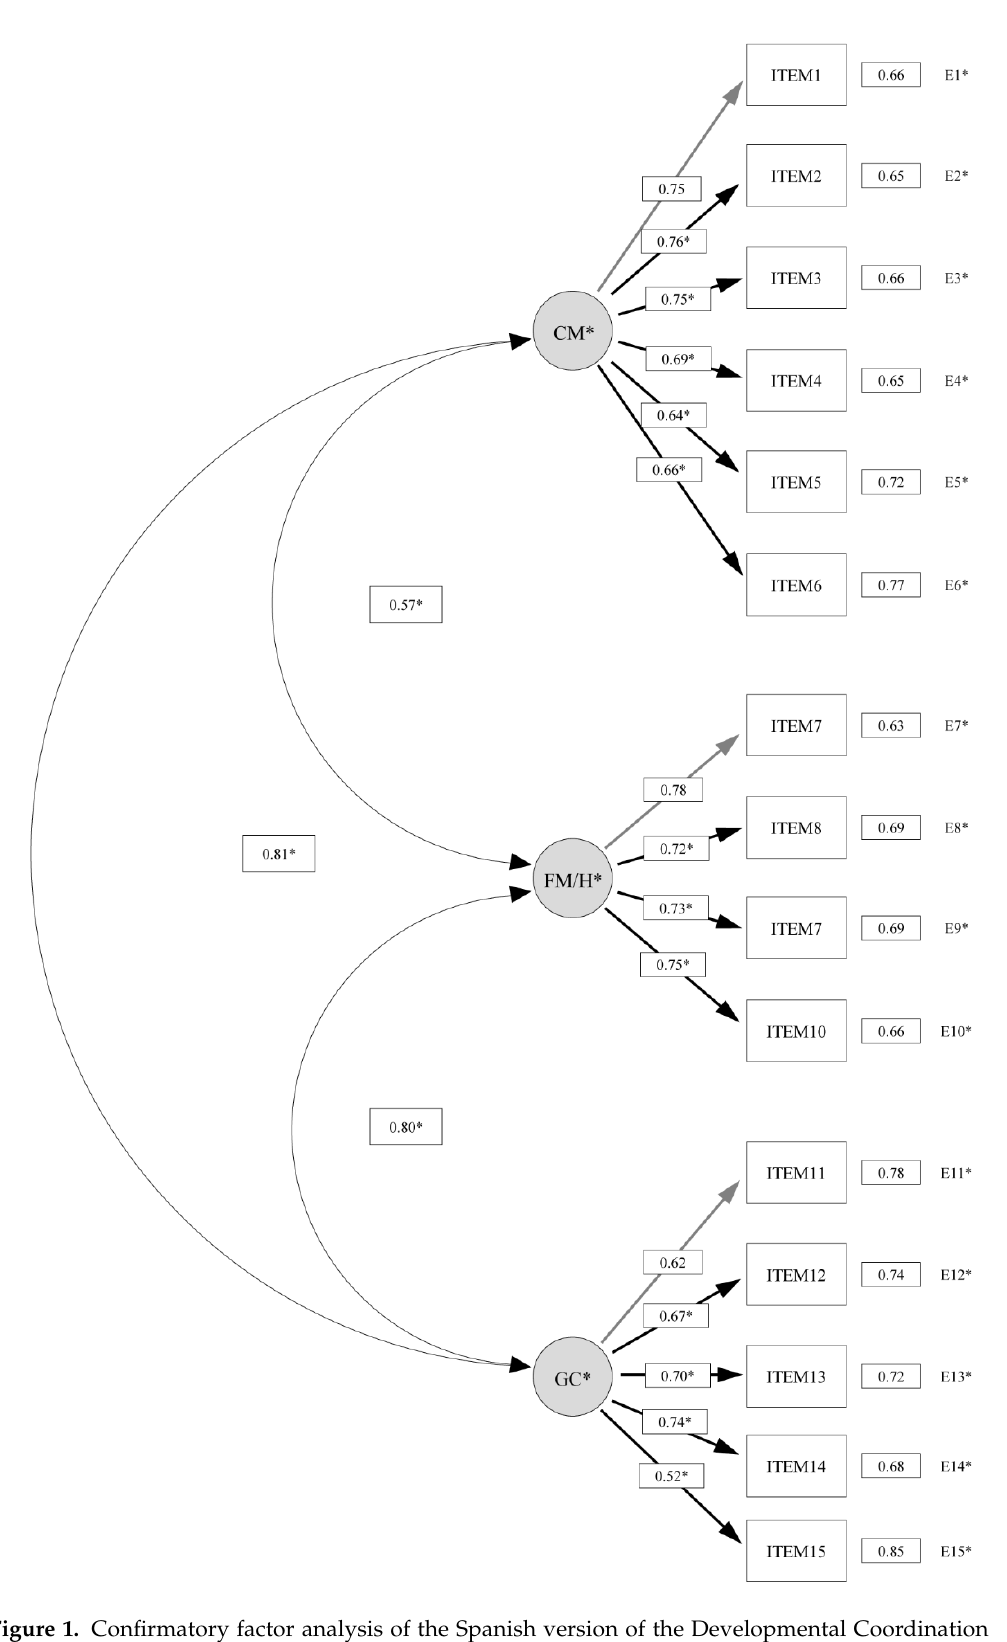
Figure 1. Confirmatory factor analysis of the Spanish version of the Developmental Coordination Disorder Questionnaire (DCDQ-ES) three-factor model ( n = 540). Items 1, 7 and 11 fixed to 1 during estimation. CM = control during movement; FM/H = fine motor/handwriting; GC = general coordination.